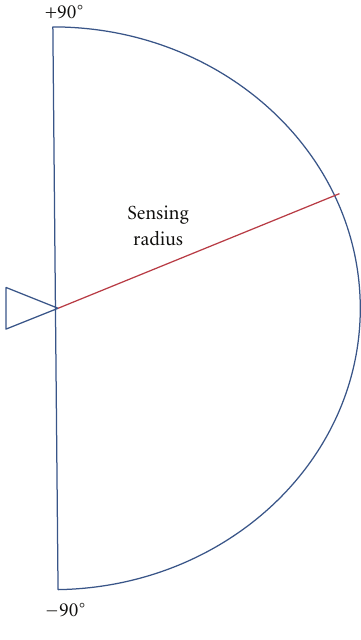
Figure 2: Sensing radius of